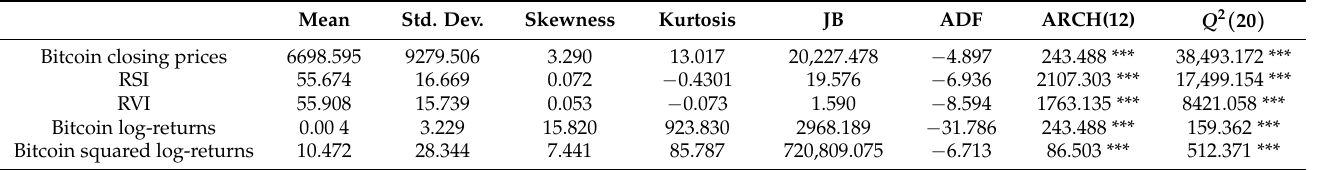
Figure 5. Actual Bitcoin returns and GARCH-type models’ estimated volatility from 1 January to 31 March 2021. Table 1. Summary statistics of Bitcoin closing prices, volatility indicators, Bitcoin log-returns, and square log-returns.